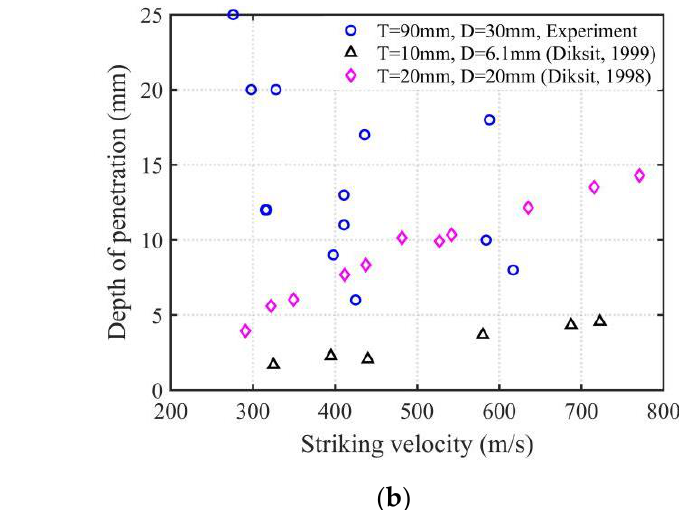
Figure 9. Variation of the damage area with the striking velocity at a 30° angle of attack.